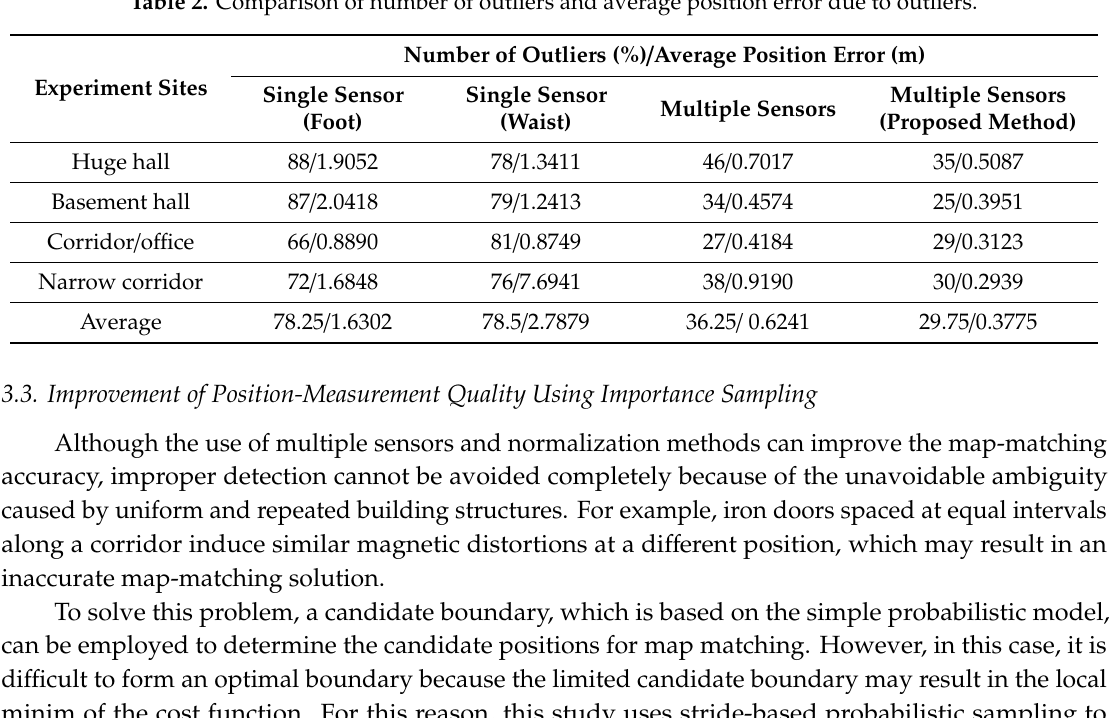
Figure 1. Scheme of the experimental procedure. Table 2. Comparison of number of outliers and average position error due to